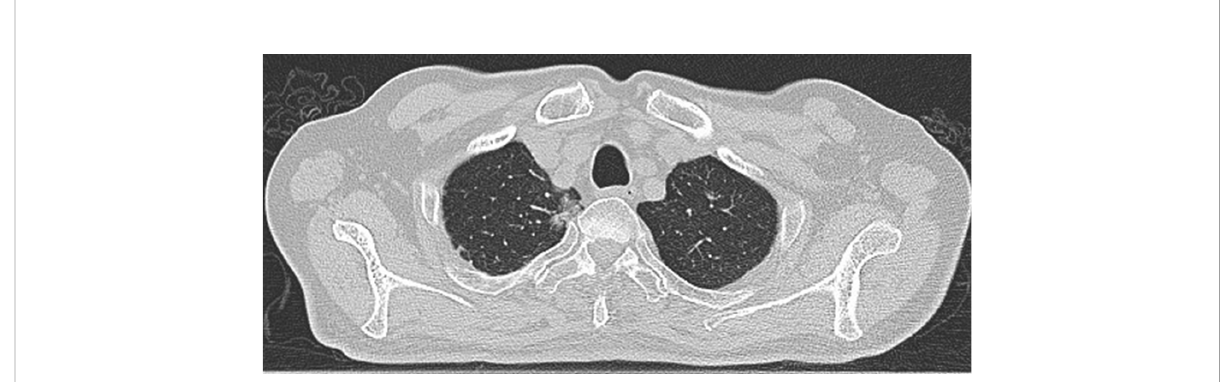
FIGURE 1 Preoperative scan: Preoperative CT showed a nodule in the right upper lobe. Invasive adenocarcinoma of the right upper lobe of a 78-year-old